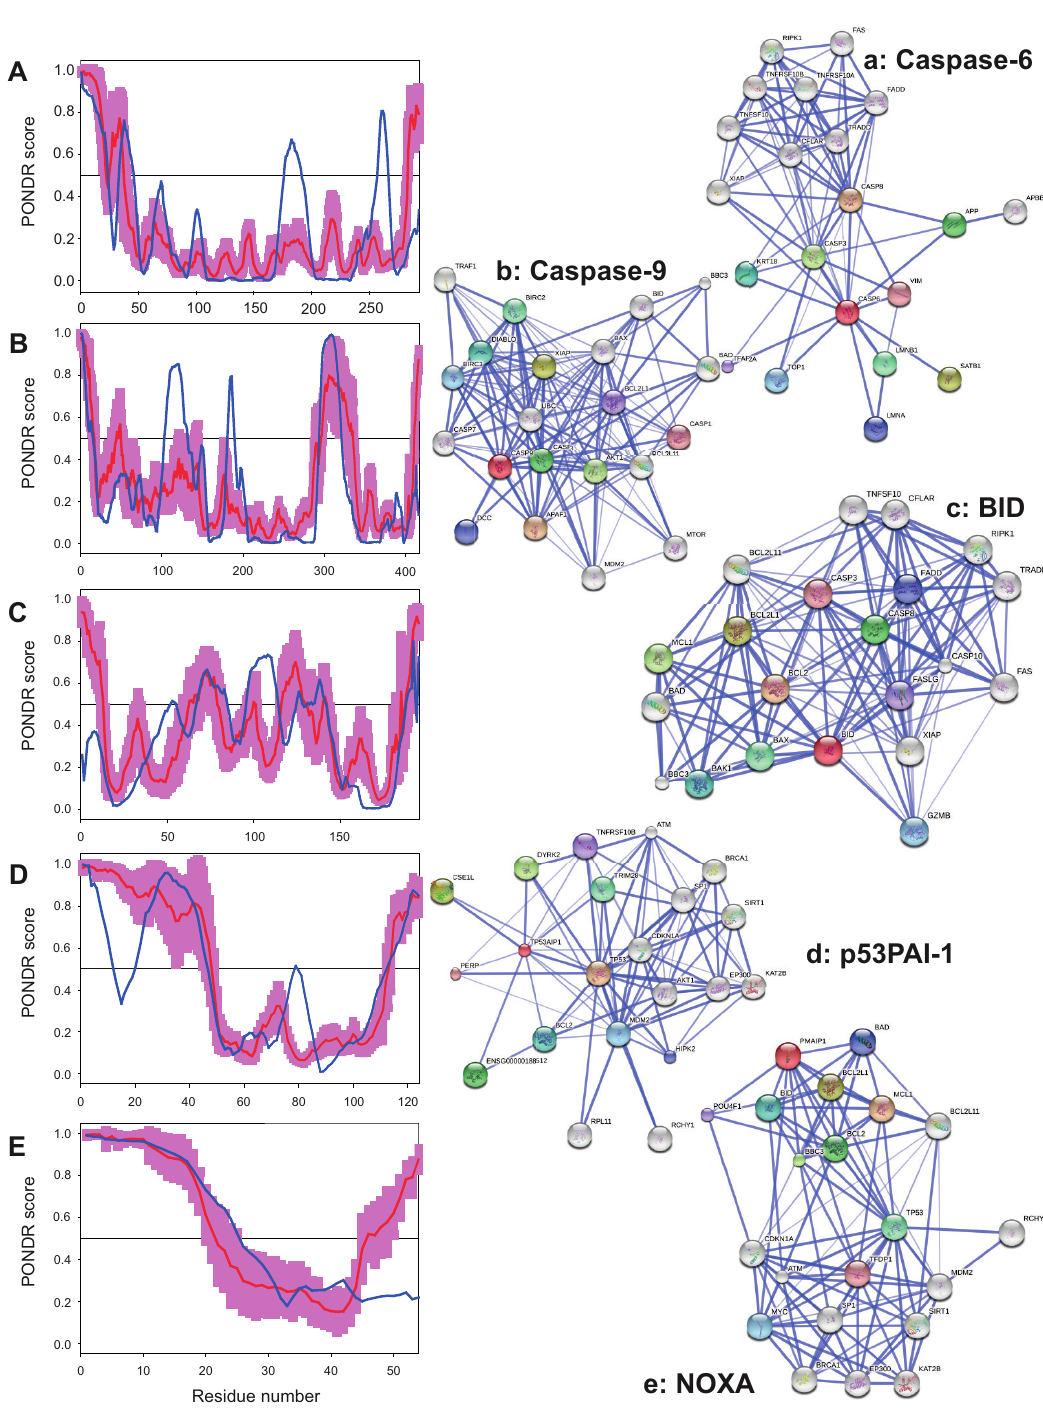
Figure 7. Intrinsic disorder (upper characters) of some human proteins involved in the p53-mediated apoptotic signaling pathways and STRING analysis (lower characters) of their interactomes: group V. A . and a . Caspase-6 (UniProt ID: P55212); B . and b . Caspase-9 (UniProt ID: P55211); C . and c . BID (UniProt ID: P55957); D . and d . p53PAI-1 (UniProt ID: Q9HCN2); E . and e . NOXA (UniProt ID: Q13794). Intrinsic disorder propensity was evaluated by PONDR-FIT (red curves and pink shadow) and PONDR ® VLXT (blue curves). The shadow around PONDR-FIT curves represents distribution of statistical errors. STRING database is the online database resource search tool for the Retrieval of Interacting Genes, which provides both experimental and predicted interaction information 92 . For each protein, STRING produces the network of predicted associations for a particular group of proteins. The network nodes are proteins. The edges represent the functional associations evaluated based on experiments, search of databases, and text mining. The thickness of edges is proportional to the confidence level 92